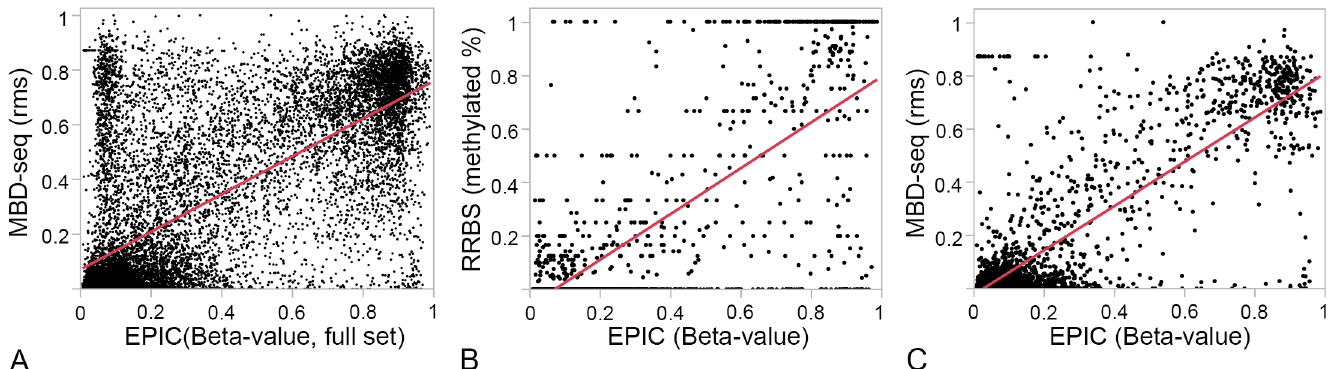
Fig 3. Correlation between MethylationEPIC and high-throughput sequencing data. Two sequencing datasets were considered for comparison. The MBD-seq was generated in-house from the same samples as the microarray data, and the mouse liver reduced representation bisulfite sequencing (RRBS) data was from a public repository. For each of the 13,665 conserved probes, the 300 bp window around the corresponding CpG was determined and the CpG density-normalized relative methylation score (rms) was estimated for that region from the MBD-seq data. (A) While there was overall significant correlation between the β -values and rms (Pearson’s correlation of 0.70, p < 0.0001), for CpGs with low β -values, the corresponding regions showed rms that cluster close to 0, and for CpG with high β -values, the corresponding rms tended to cluster close to 0.75. ( B) For the RRBS data, 2,548 CpGs intersected with the list of 13,665 CpGs interrogated by the conserved EPIC probes. For most CpGs, methylation levels were concordant between the RRBS and EPIC (R = 0.78, p < 0.0001). However, sequence coverage was low for several CpGs in the RRBS data (average total read counts of < 7) and such CpGs were associated with estimated methylation fraction of 0 or 1. (C) For the smaller subset of 2,548 CpGs, the β -values showed a more linear correlation with the MBD-seq data (R = 0.84, p < 0.0001).